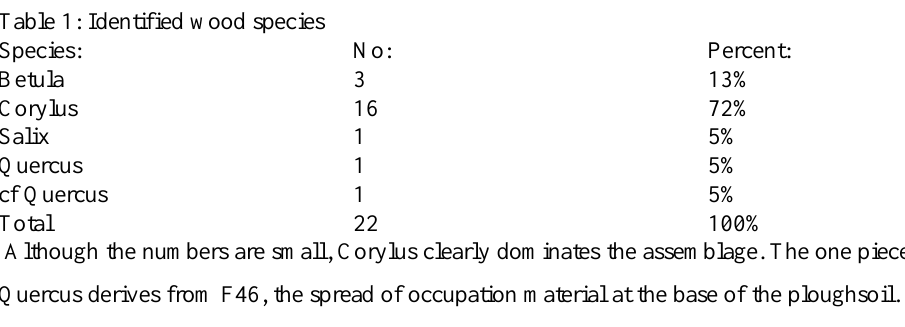
Table 1: Identified wood